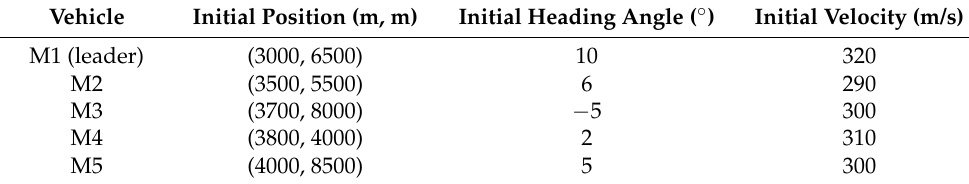
Table 1. The initial conditions of the interceptors.